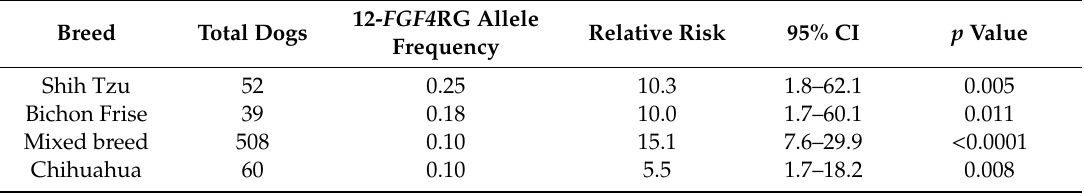
Table 6. Relative risk associated with 12- FGF4 RG for IVDD. Dogs included in the IVDD categories were at least 10 years of age as of their last visit to the VMTH. Breed allele frequencies information is taken from dogs with no diagnosis of IVDD (Supplementary Table